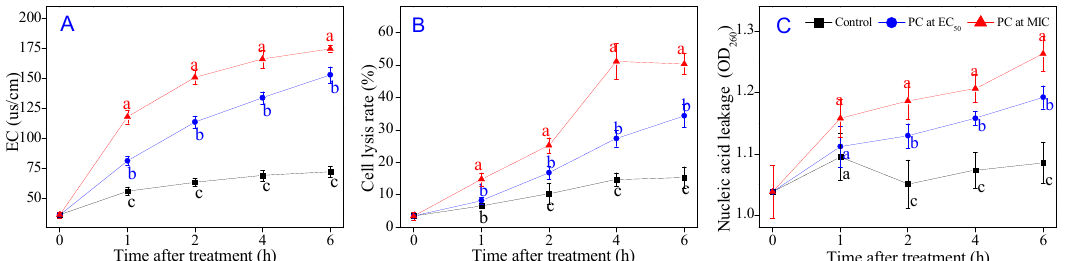
Figure 5. E ff ects of P7G on extracellular conductivity ( A ), cell lysis rate ( B ) and nucleic acid leakage ( C ) of P. italicum in potato dextrose broth (PDB). Each value is the mean of three replicates ( n = 3), and the vertical bar indicates the standard error (S.E.). The values with di ff erent lowercase letters within the same time point indicate a significant di ff erence between the control and the P7G-treated mycelia according to Duncan’s test at p <